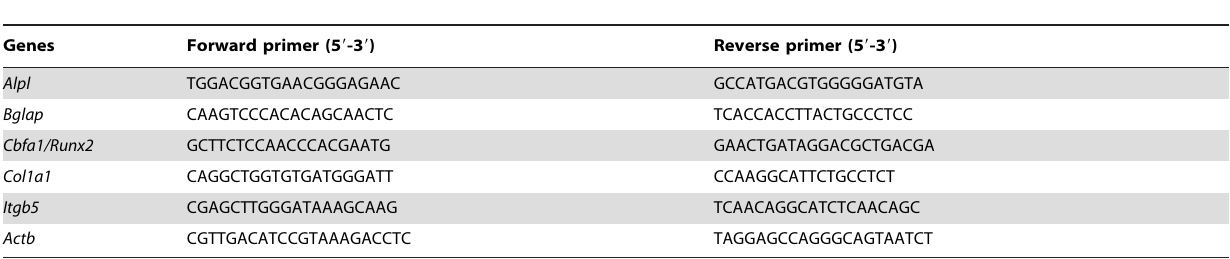
Table 1. Primer sequences for real-time RT-PCR.